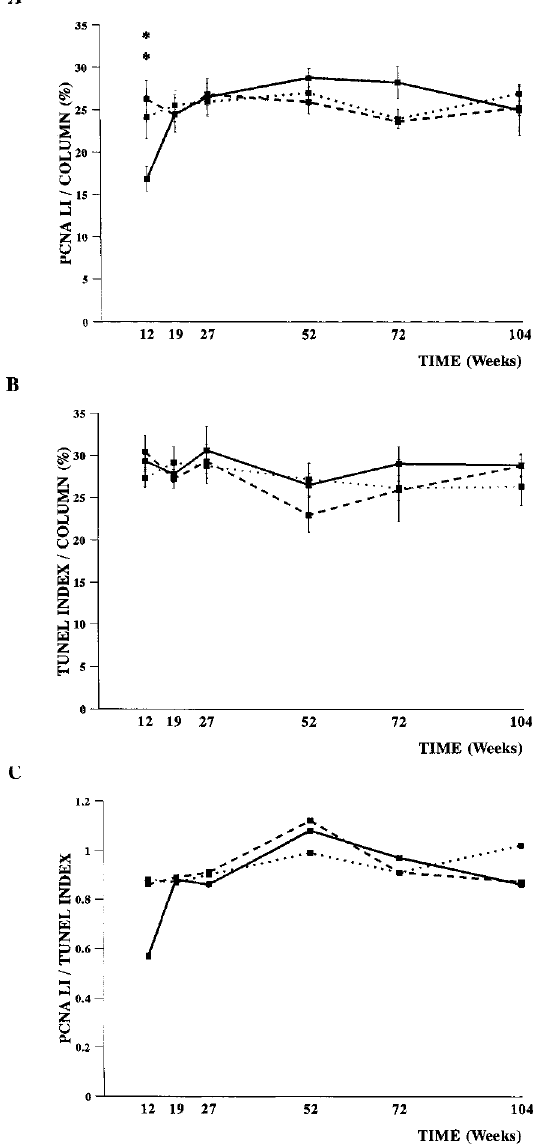
Fig. 1. PCNA LI (A), TUNEL Index (B) in the whole crypt column, and PCNA LI / TUNEL Index ratio (C) during the rodents’ life span. (Control Diet, CD: ___; Western Diet A, WDA: (cid:1)(cid:1)(cid:1) ; Western Diet B,